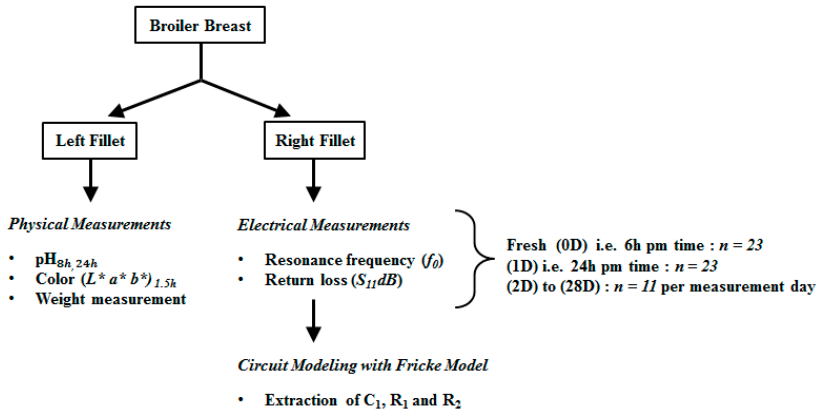
Figure 6. Experimental design for physical and electrical measurements.